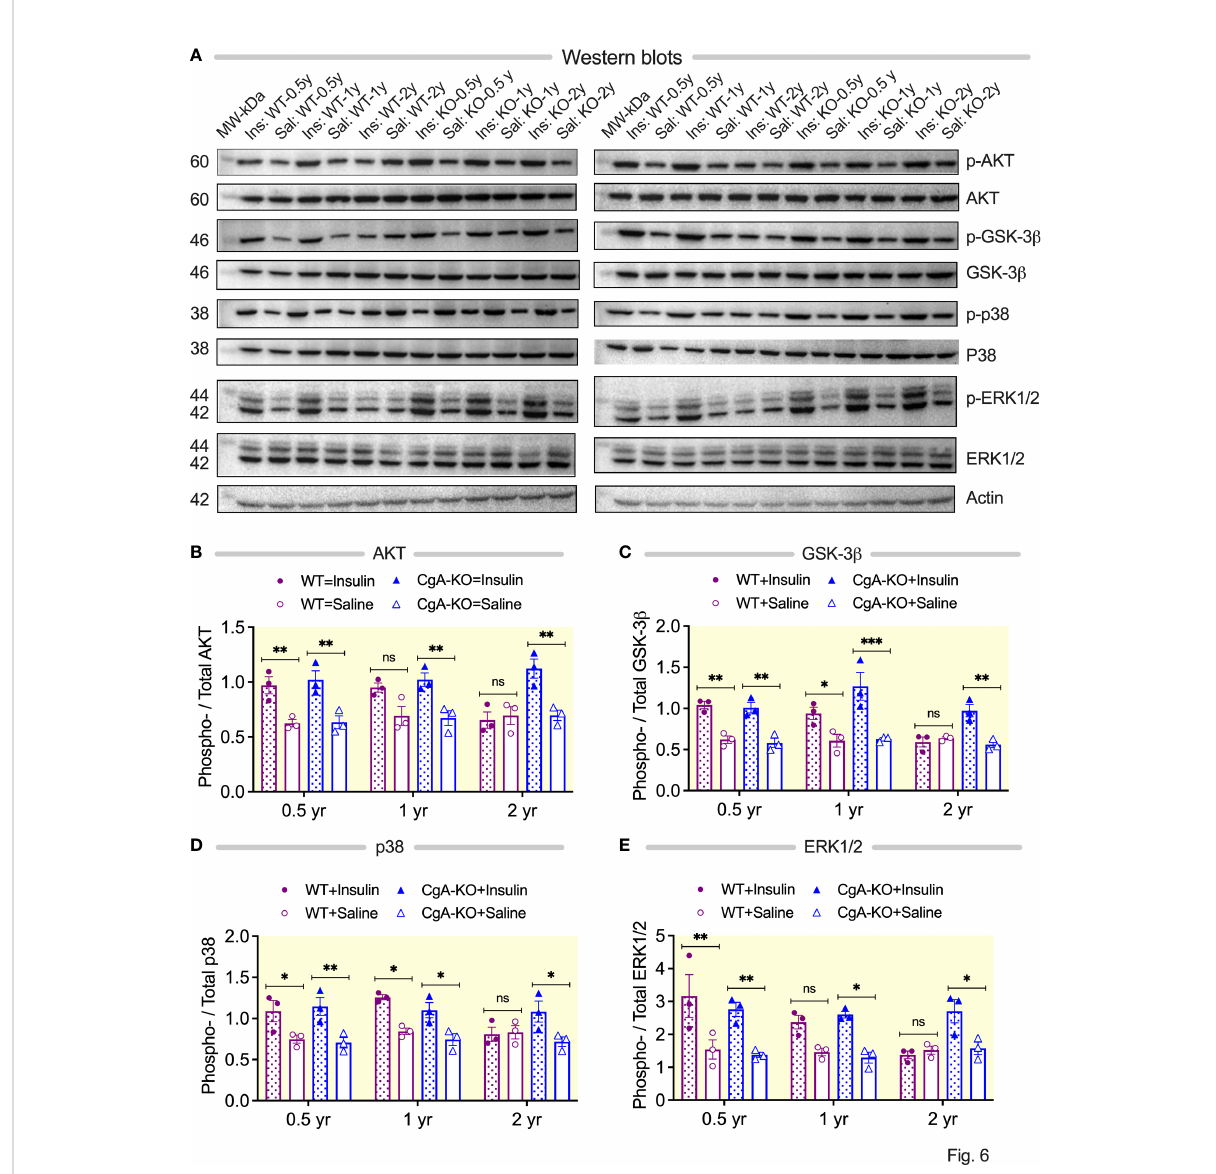
FIGURE 6 Aging CgA-KO mice maintain insulin signaling pathways. (A) Western blots of phosphorylated-AKT (S473), total AKT, phosphorylated GSK-3 b (S9), total GSK-3 b , phosphorylated p38 (T180/Y182), total p38, phosphorylated ERK1/2 (T202/Y204), and total ERK1/2 in the livers of 2 sets of aging WT and CgA-KO mice. (B – E) Densitometric analyses of the Western blots by 3-way ANOVA (n=3). (B) AKT (phosphorylated/total AKT). Age: ns; Genotype: p<0.01; Treatment: p < 0.001; Age x Genotype: p < 0.05; Age: x Treatment: ns; Genotype: x Treatment: p < 0.01; Age: x Genotype: x Treatment: p < 0.05. (C) GSK-3 b (phosphorylated/total GSK-3 b . 3-way ANOVA: Age: p < 0.01; Genotype: ns; Treatment: p < 0.001; Age: x; Genotype: ns; Age: x Treatment: p < 0.05; Genotype: x Treatment: p < 0.05; Age: x; Genotype: x; Treatment: ns. (D) p38 (phosphorylated/total p38). Age: ns; Genotype: ns; Treatment: p < 0.001; Age: x Genotype: ns; Age x Treatment: ns; Genotype: x Treatment: p < 0.05; Age x Genotype: x Treatment: p < 0.05. (E) ERK1/2 (phosphorylated/total ERK). Age: ns; Genotype: ns; Treatment: p < 0.001; Age